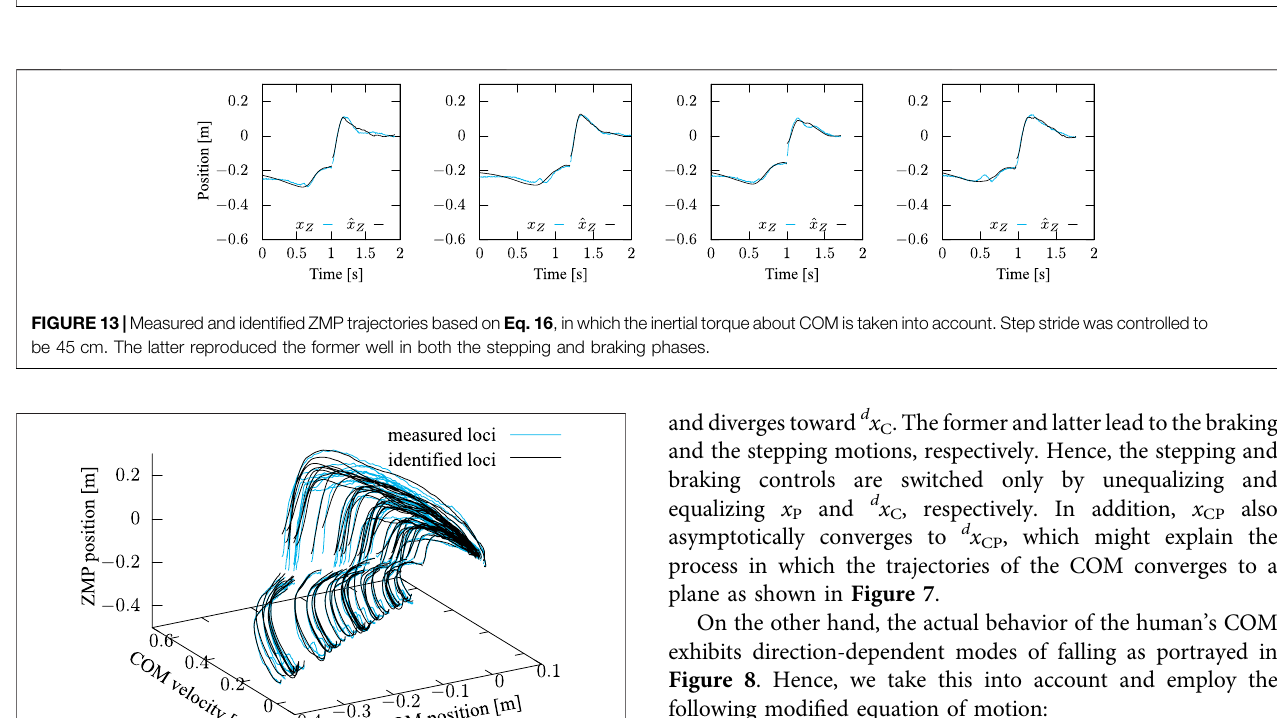
FIGURE 12 | Measured and identi fi ed ZMP trajectories based on Eq. 14 , in which the inertial torque about COM was ignored. Step stride was controlled to be 45 cm. While the latter reproduced the former well in the stepping phase, substantial errors are observed after landing.